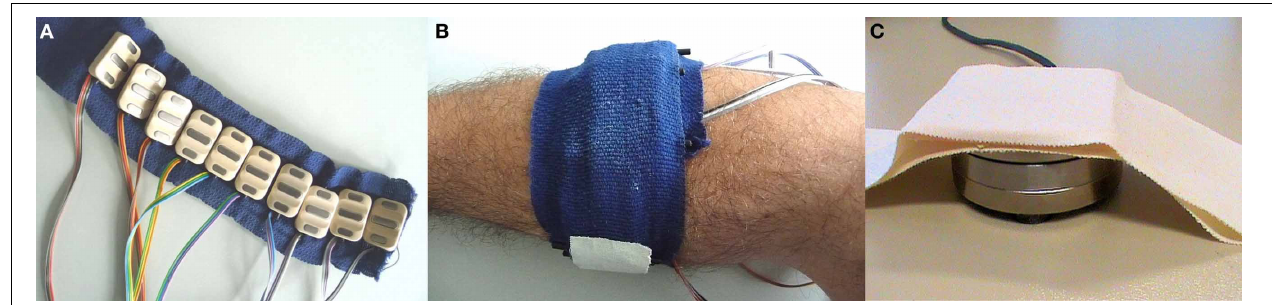
FIGURE 1 | The setup of the first experiment. (A) Ten OttoBock MyoBock 13E200 sEMG electrodes, uniformly arranged (B) on the subject’s forearm using a band of bio-compatible adhesive tape. (C) An ATI Mini45 force sensor, kept in place using double-sided